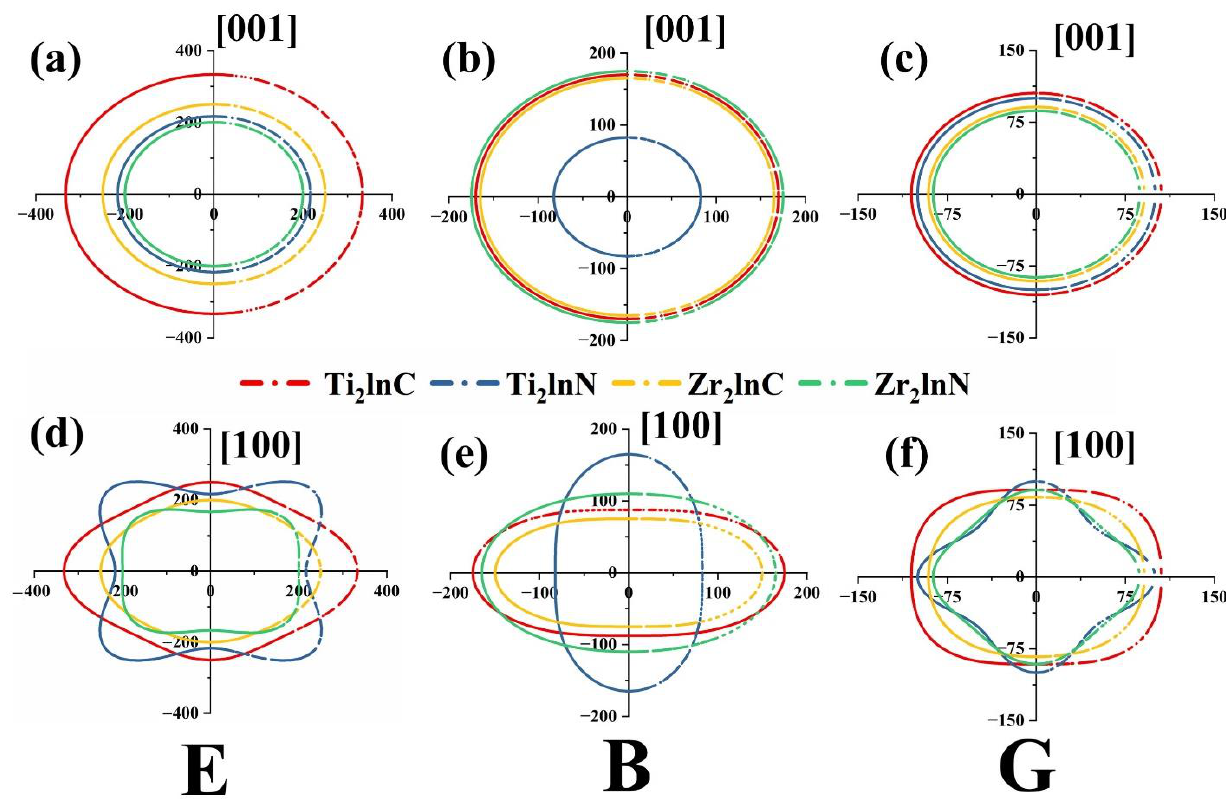
Figure 8. Projections of E ( a , b ), B ( c , d ) and G ( e , f ) of M 2 InX (M = Ti, Zr and X = C, N) MAX phases. The unit is GPa. Table 5. Calculated uniaxial elastic moduli in the [100], [010] and [001] directions (in GPa) of M 2 InX (M = Ti, Zr and X = C, N) MAX phases.